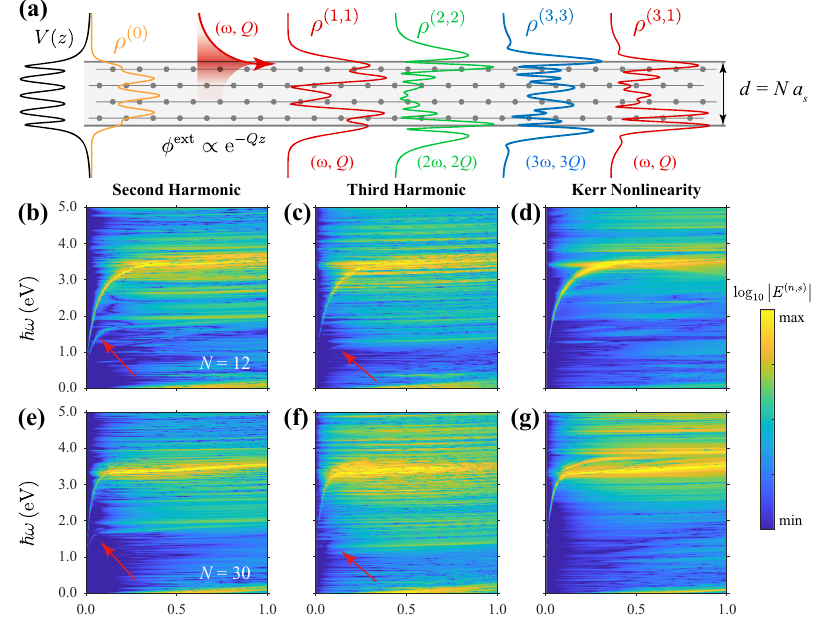
Figure 2: Nonlinear response of crystalline silver films. (a) Schematic illustration of the atomic layer potential V ( z ) (black curve), background electron density 𝜌 (0) (orange curve), external potential with fixed fre- quency 𝜔 and in-plane wave vector Q , and induced charge density components 𝜌 ( n , s ) corresponding to processes of order n and harmonic s in a film consisting of N = 4 Ag(111) atomic layers. We take Q = 0 . 1 nm − 1 and ℏ𝜔 = 1 . 85 eV to lie on the SPP